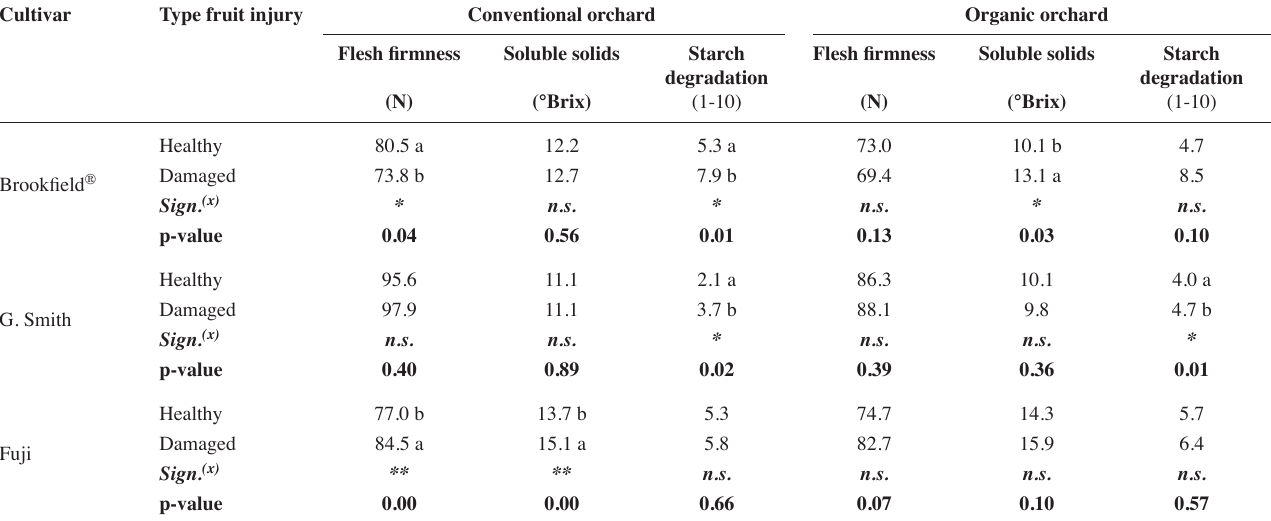
Tab. 3: Maturity index in three cultivars at harvest from conventional and organic orchards. Cultivar